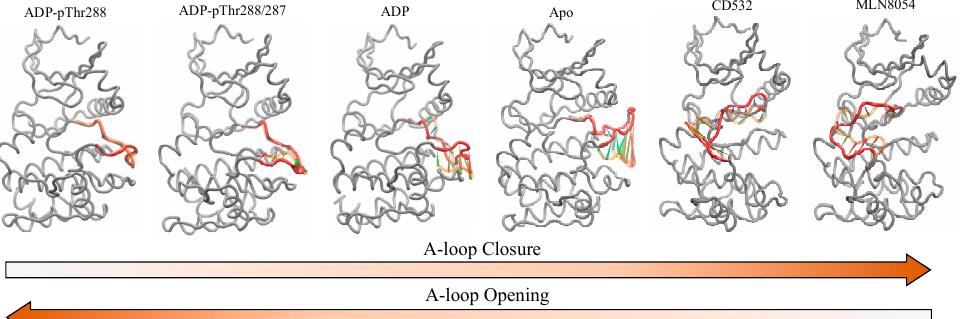
Figure 9. Porcupine plot showing the significant motions of the A-loop of Aurora-A, including the open/active states: ADP/Mg with single TPO (1OL7), ADP/Mg with two TPO (1OL7), ADP/Mg (1MQ4), apo (4J8N), and the closed/inactive states: CD532 (4J8M) and MLN8054 (2WTV). The A-loop is colored red (residues 274-299), and the first position of the A-loop is indicated in light orange. Arrows show the direction of the correlated motion. Red reflects the highest movement followed by green, whereas blue depicts the least moving parts of the protein.